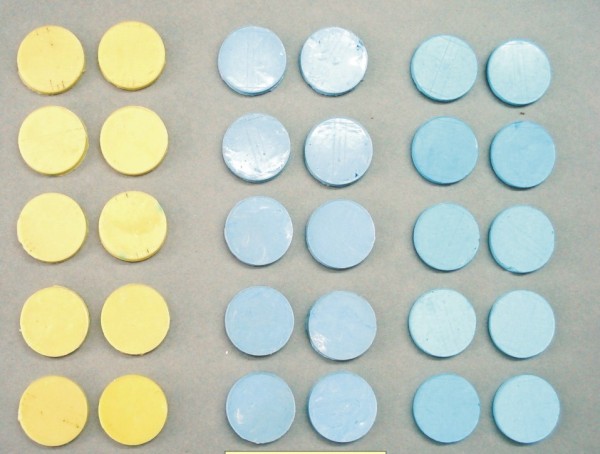
Test samples-yellow polyether-blue middlecolumn ZnoE-blue Polyvinyl siloxane.